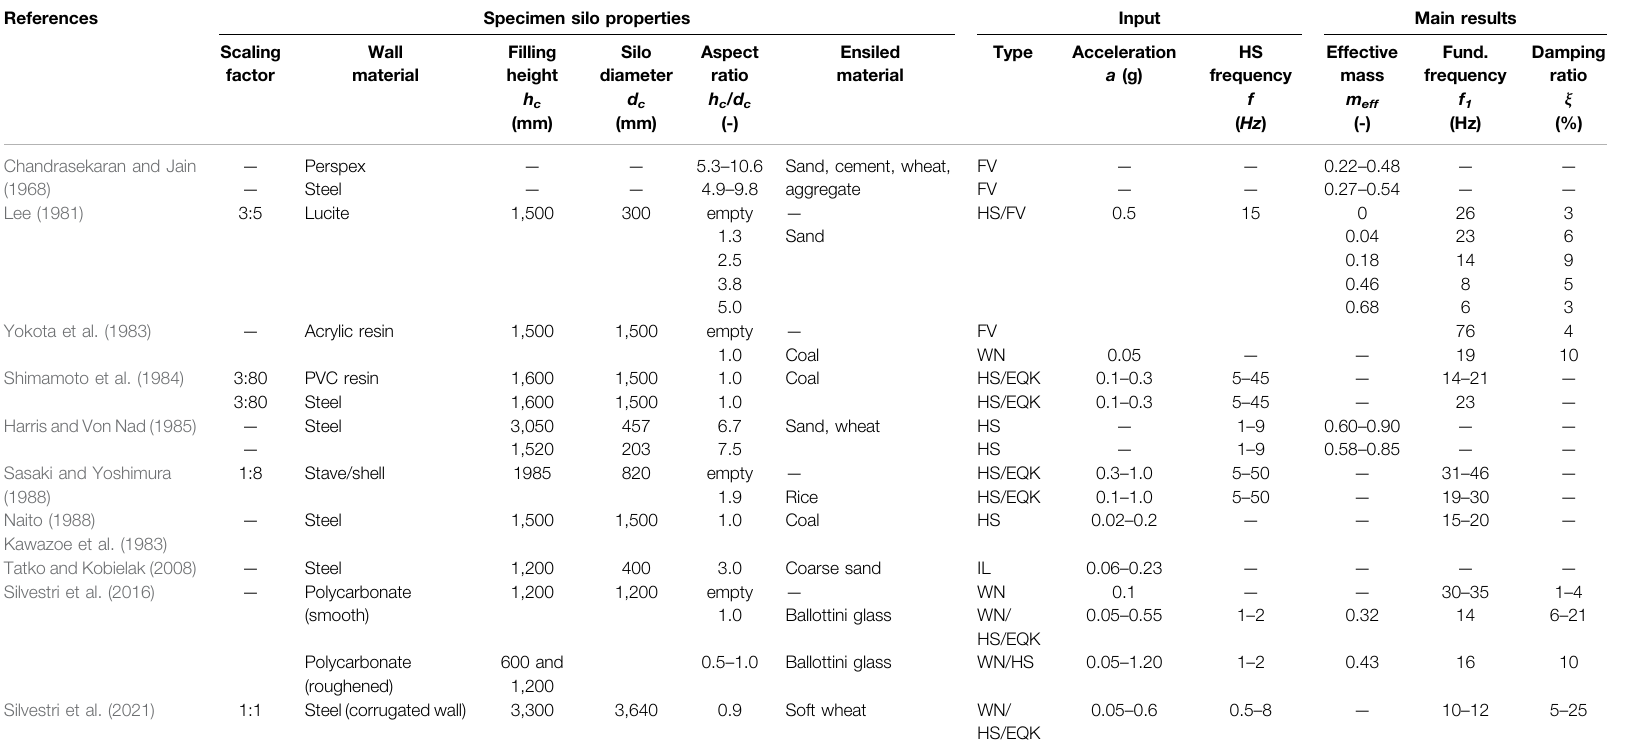
TABLE 2 | Summary of the main experimental results of dynamic tests on fi lled silo systems found in the scienti fi c